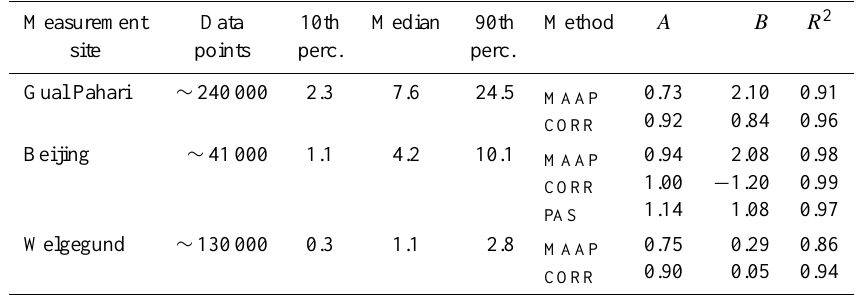
Table 1. Linear regression analysis of BC MAAP , BC CORR and BC PAS against BC REFL at three ambient locations. 10th percentile, median and 90th percentile of the concentrations (in µgm − 3 ) are also shown. Measurement Data 10th Median 90th Method A B R 2 site points perc. perc. Gual Pahari ∼